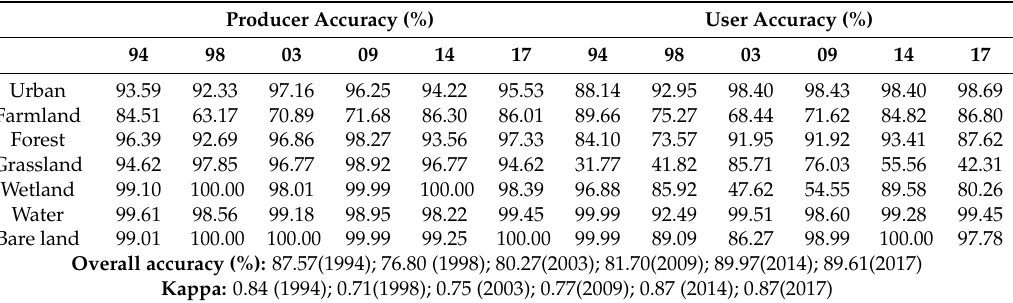
Table 2. The accuracy assessment of landscape maps from 1994 to